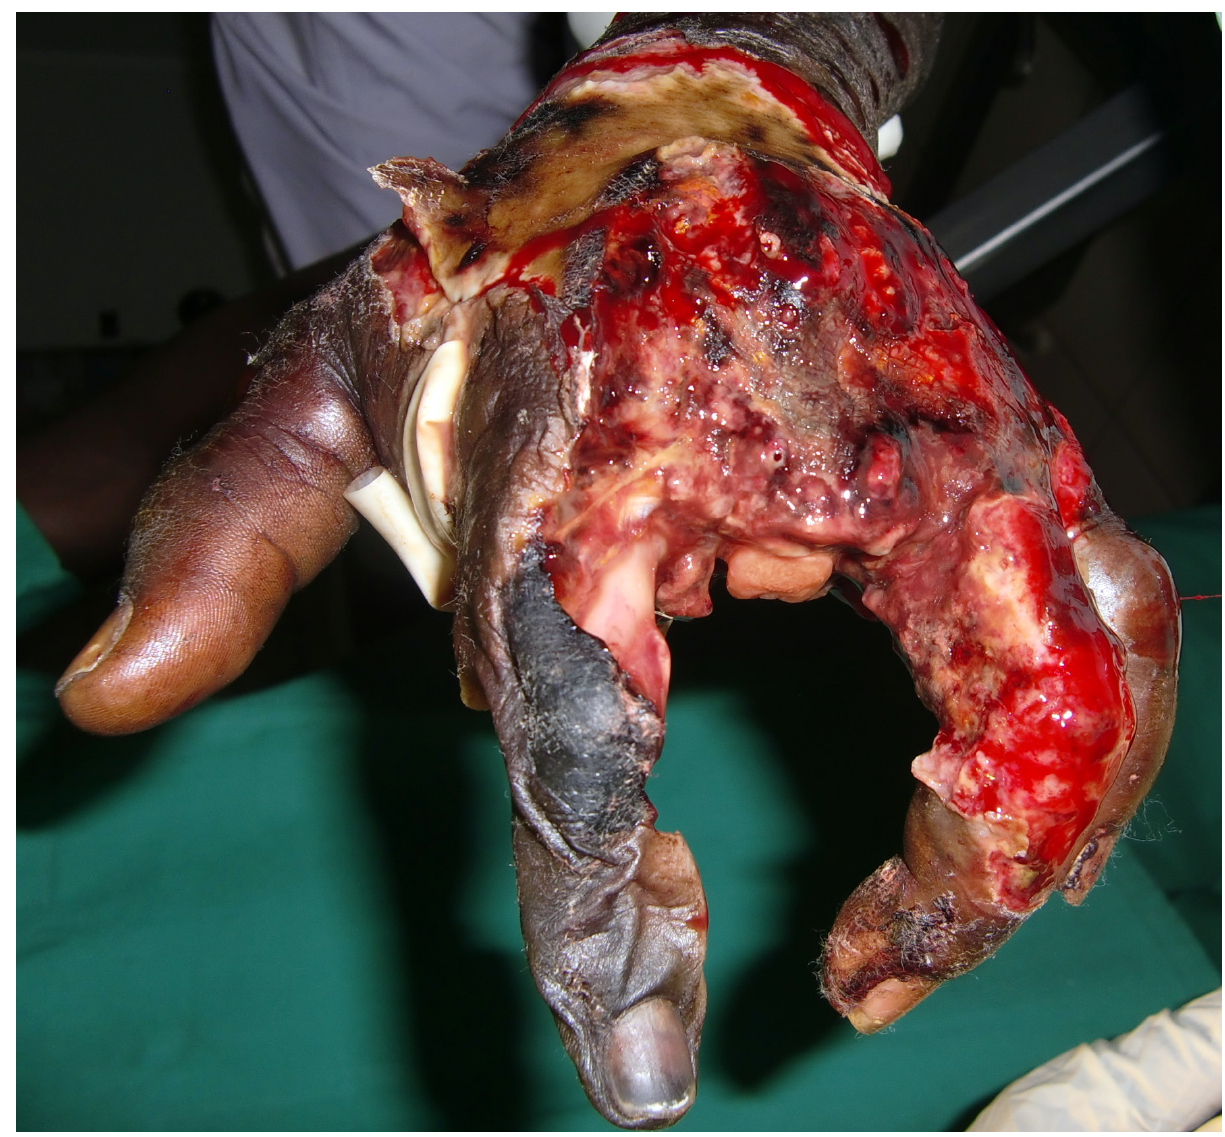
Figure 10. Finger amputation and